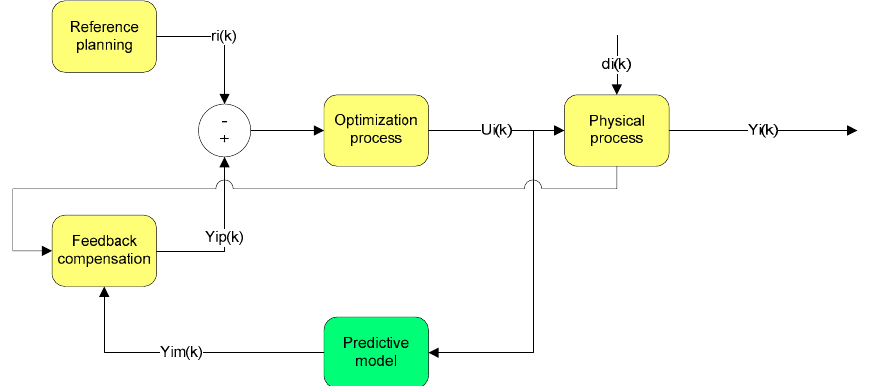
Figure 13. Flowchart of typical MPC.